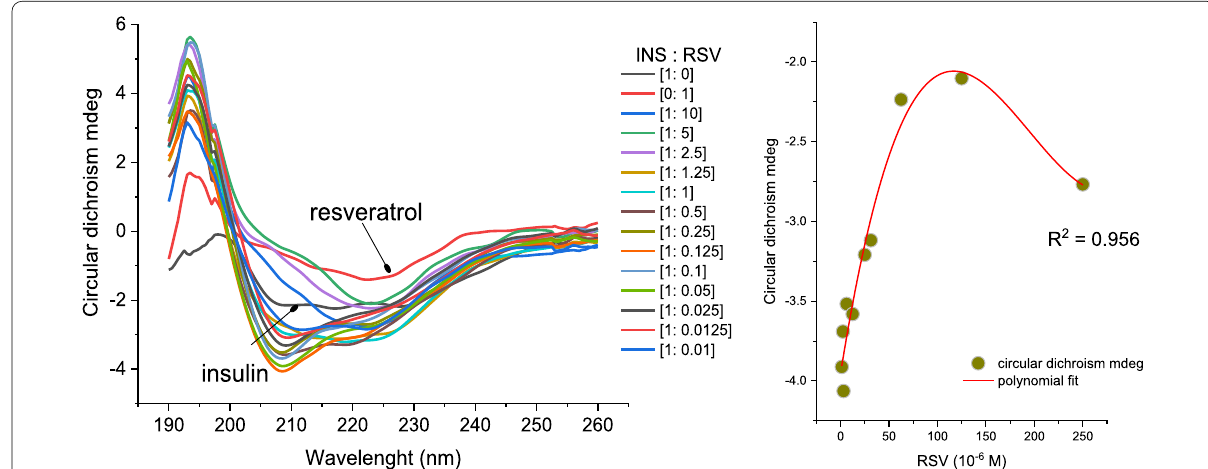
Fig. 6 a Circular dichroism spectra and b polynomial fit of circular dichroism millidegrees in INS‑RSV solution, set in a bandwidth of 1 nm, standard sensitivity mode, data pitch of 0.5 nm, scanning 50 nm/min, continuous scan mode, range 190–260